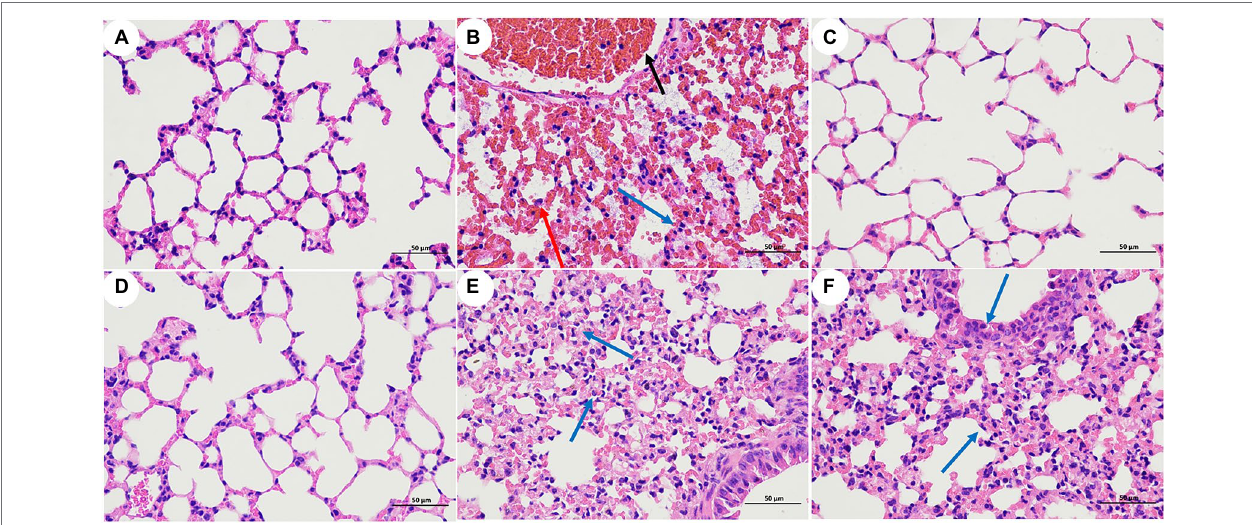
FIGURE 5 | Pathological section of mouse lung tissue (H.E, 400×). (A) Blank control group. (B) Bacterial challenge group. (C) LysCA safety group. (D) LysG24 safety group. (E) LysCA treatment group. (F) LysG24 treatment group. Necrotic cell fragments (red arrows); Inflammatory cells (blue arrow); and Bleeding (black arrow).